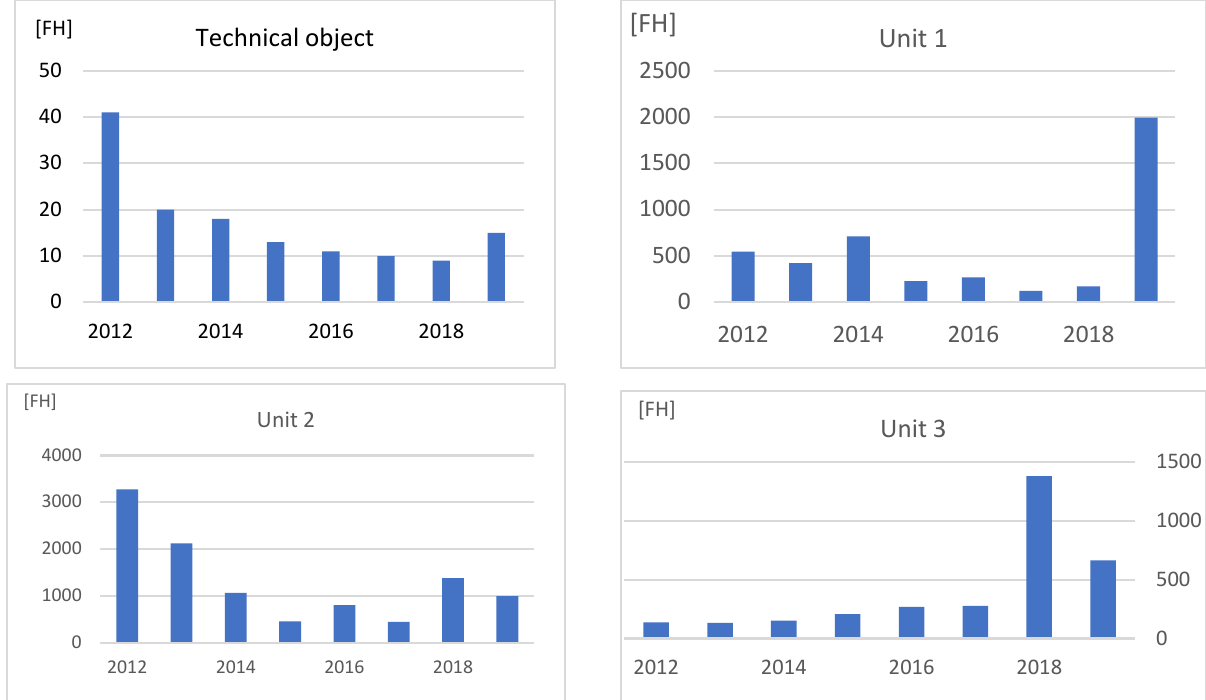
Figure 5. Trend of change in annual MTTF D over 2012–2019 for selected equipment built on a training helicopter.